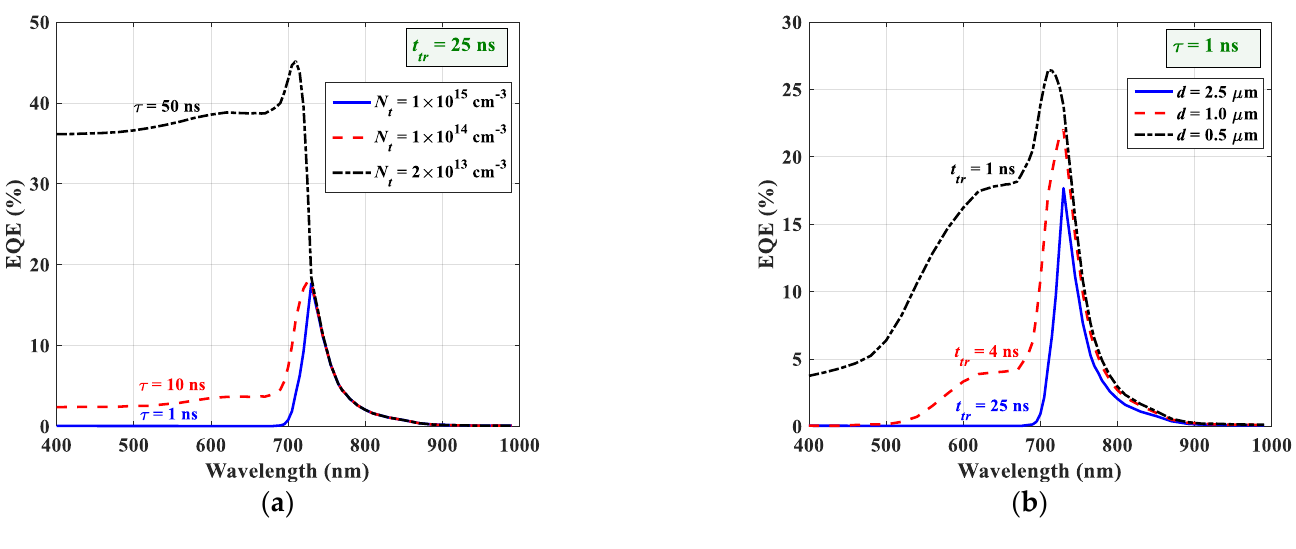
Figure 3. EQE Simulation results for different values of ( a ) trap densities and ( b ) thickness of per- ovskite layer.